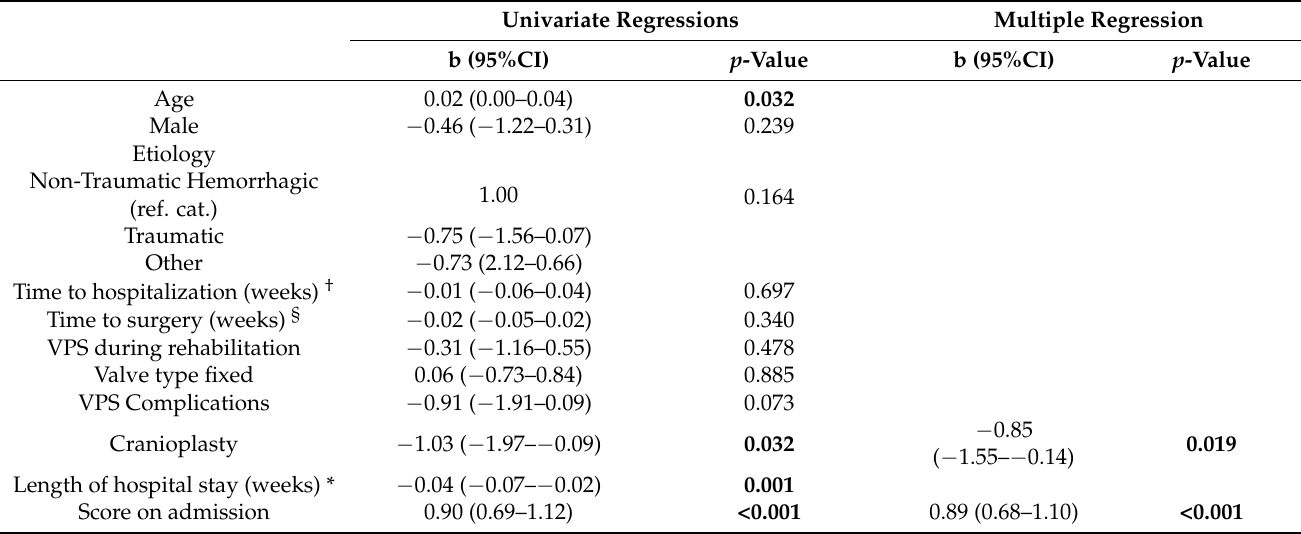
Table 4. Factors associated with cognitive function (LCF score) at discharge: results from univariate and multiple linear regression analyses. Significant associations are shown in boldface.